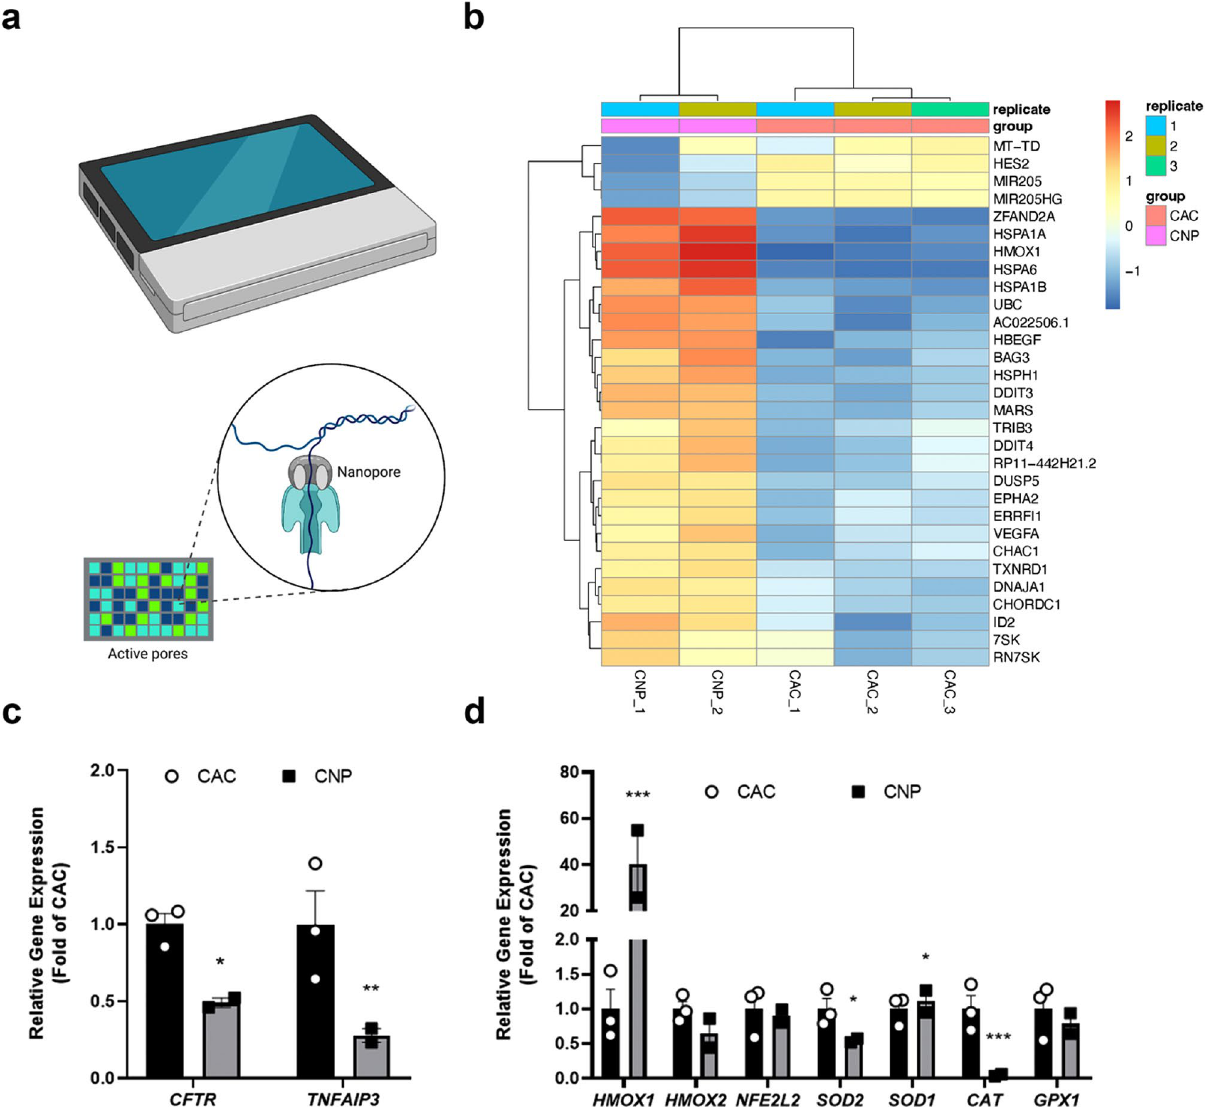
Figure 4. RNA-Seq analysis of 16HBE14o- cells exposed to clean air control or spark-ablated CNP. ( a ) RNA-Seq analysis was performed using a minION device (ONT, top). DNA or RNA molecules pass through a pore and cause alterations in electric signal when passing through the pore (bottom). Eventually, these signal fluctuations are further translated (basecalled) into distinct bases with special algorithms ( b ) Heat Map analysis of RNA-Seq data. Visualized are the 30 top differentially expressed genes in a heatmap plot and genes ranked by Wald test p-value, then clustered by hierarchical clustering ( c ) CFTR and TNFAIP3 expression or ( d ) oxidative stress markers. Data are expressed as fold of clean air control (CAC). Data are mean ± SEM of two (CNP) or three (CAC) independent experiments. Statistical significance was calculated using the DESeq2 algorithm as described in the method section. * p < 0.05; ** p < 0.01; *** p <